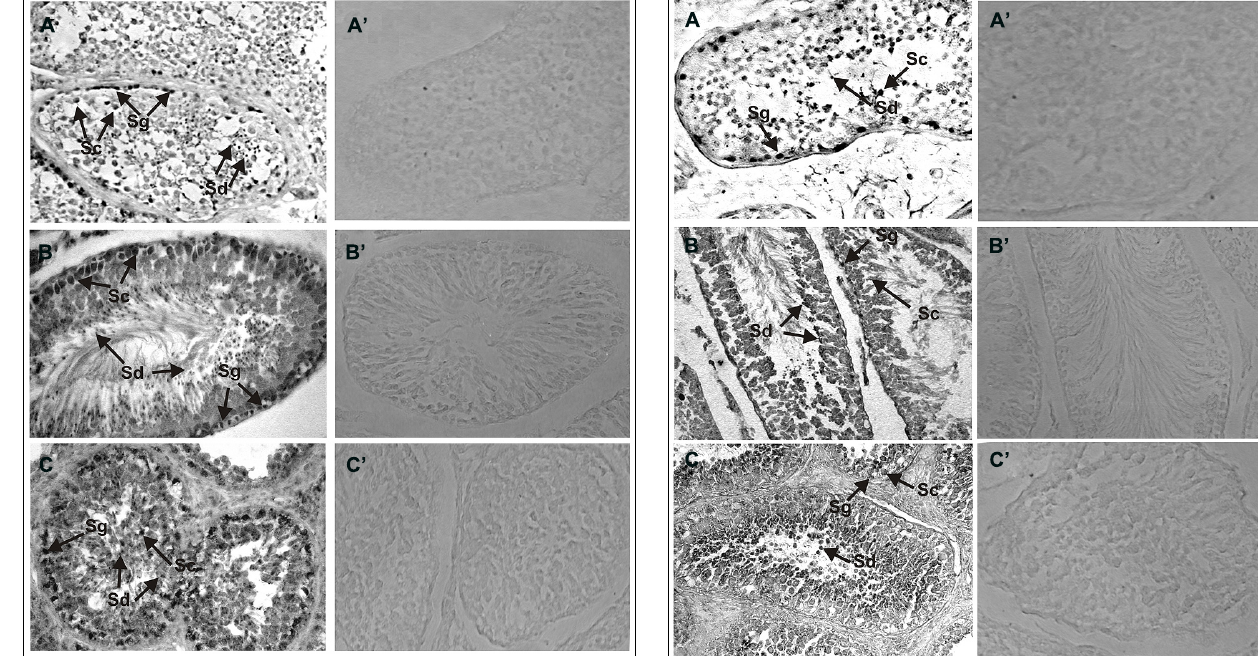
mice ( Figure 5 : panel“Ca 2 + ”). However, the cyclase activity deter- mined in the presence of Ca 2 + was strongly dependent on the mice genotype. With 1 μ M Ca 2 + present in the assay mixture the activity was 248 ± 17 pmol cyclic GMP min − 1 (mg prot) − 1 for the wild type mice and 148 ± 16 pmol cyclic GMP min − 1 (mg prot) − 1 for the NC δ + / − mice ( Figure 5 : panel “ + Ca 2 + – basal”). These results, as predicted, demonstrate that the Ca 2 + -dependent NC δ -modulated ROS-GC1 signaling pathway in the mice with one copy of NC δ gene deleted (NC δ + / − ) is about half as active as in the wild type mice. To further validate that the lowering of the Ca 2 + -dependent cyclase activity in the membranes of NC δ + / − mice is the exclusive consequence of lower NC δ expression, 4 μ M exogenous NC δ was added to the wild type and NC δ + / − mem- branes and the cyclase activity was assessed in the presence of 1 μ M Ca 2 + . The cyclase activity in the wild type membranes increased only minimally, from 248 to 273 ± 25 pmol cyclic